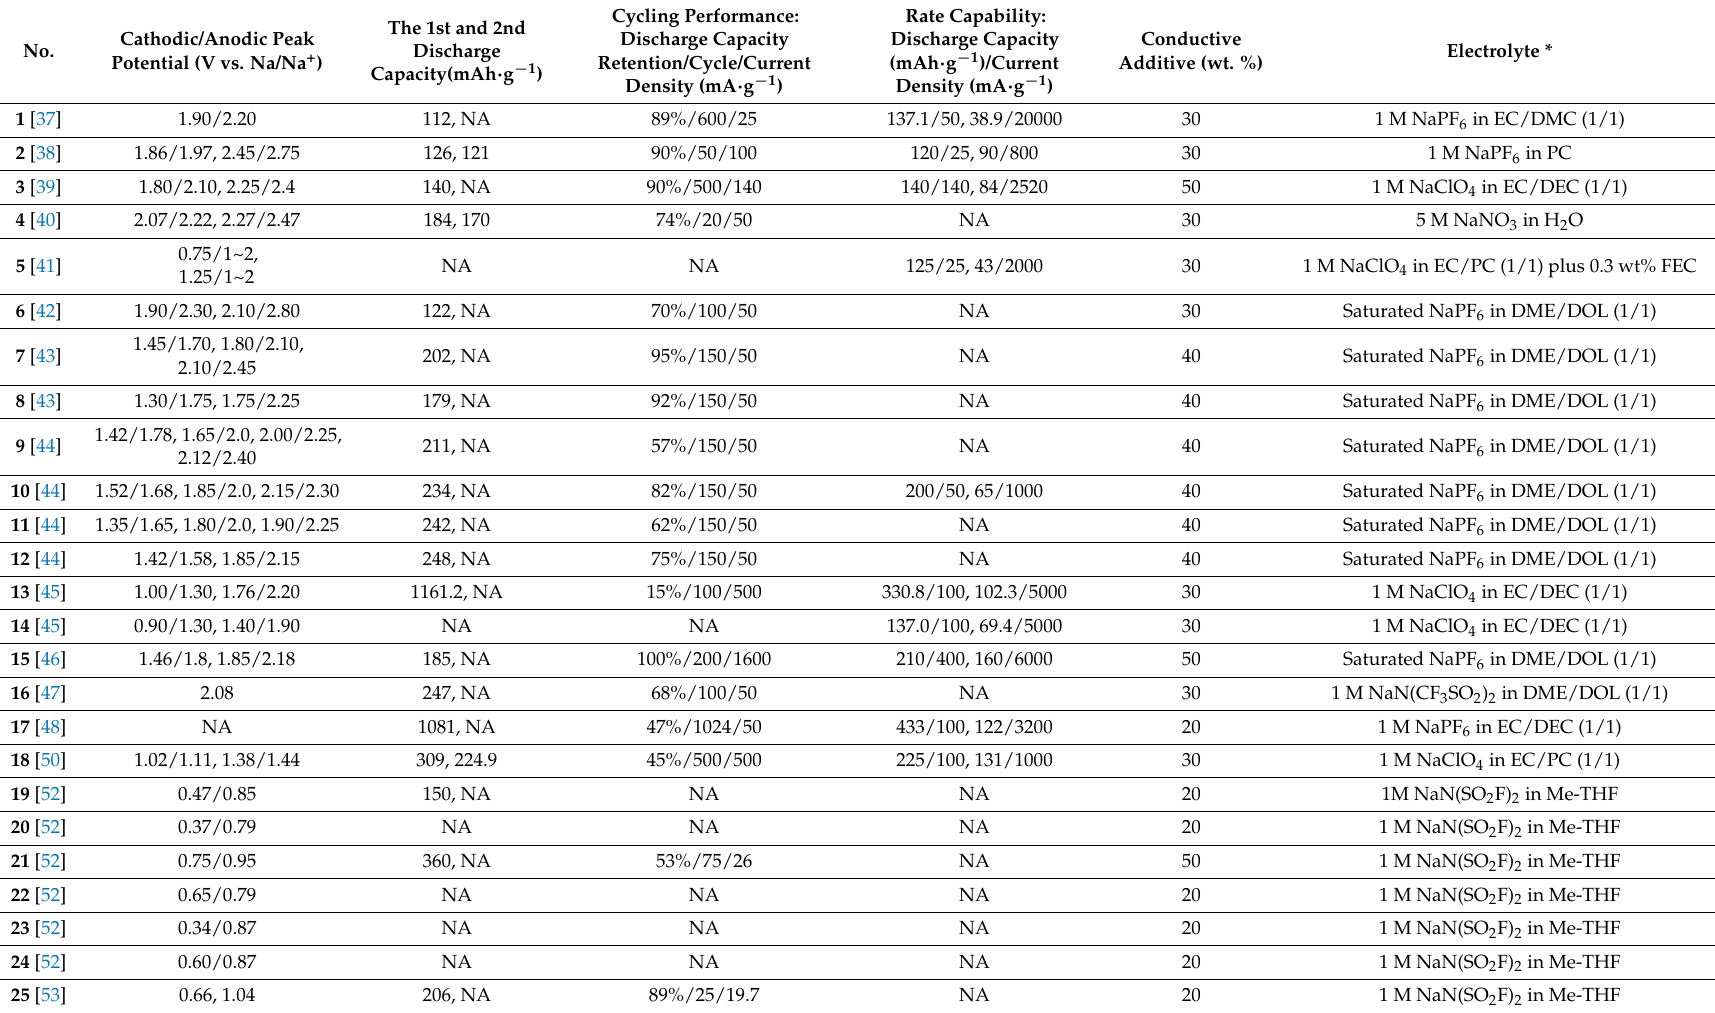
Table 2. Summary of electrochemical properties of some polymer electrode